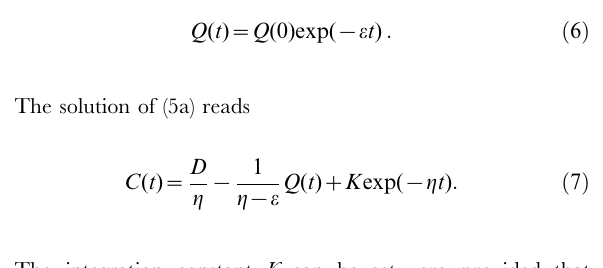
Table 2. In a one sample T-test with these E -values a significant positive effect of dieting was found with p = 0.000 (0.009). In